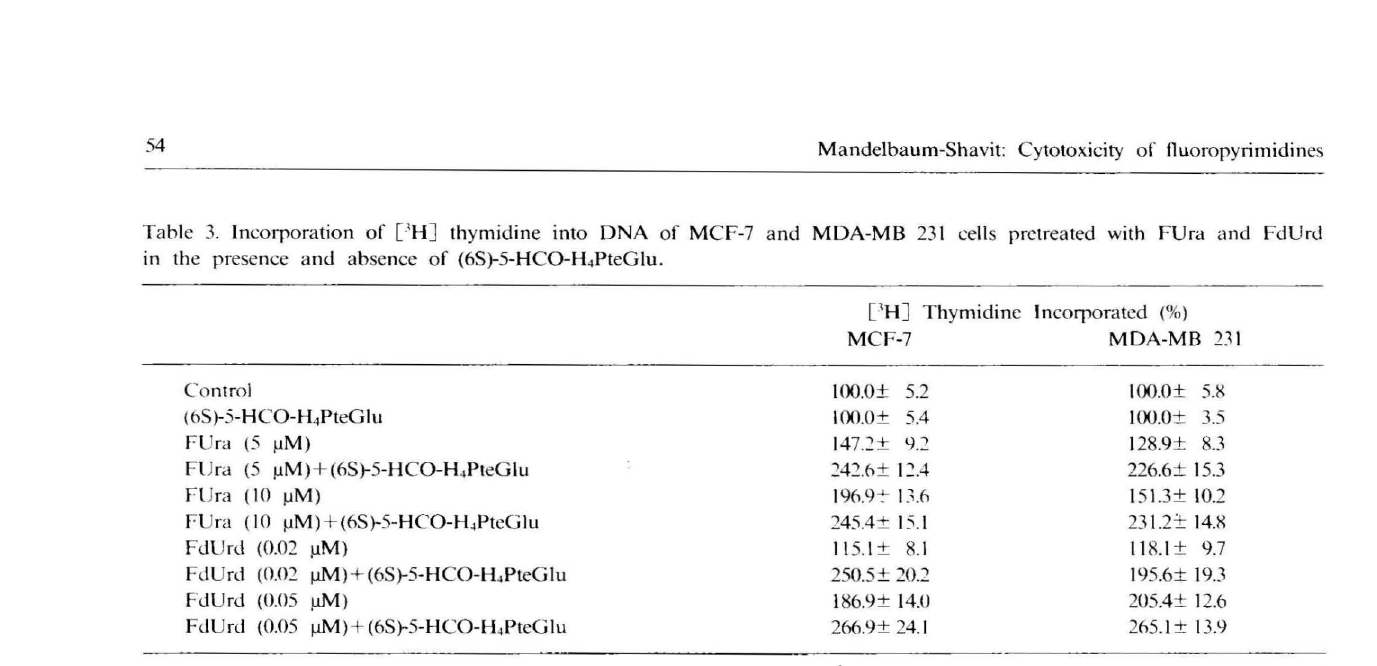
Table 3. Incorporation of ['HJ thymidine into DNA of MCF-7 and MDA-MB 231 cells pretreated with FUra and FdUrd in the presence and absence of (6S)-S-HCO-H 4